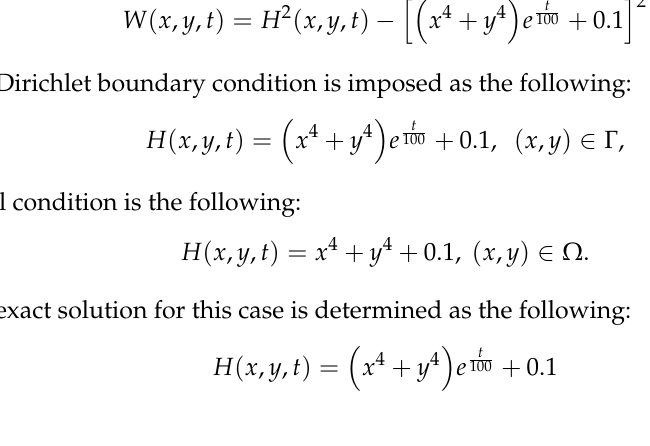
Figure 11. The dimension of a gear domain.